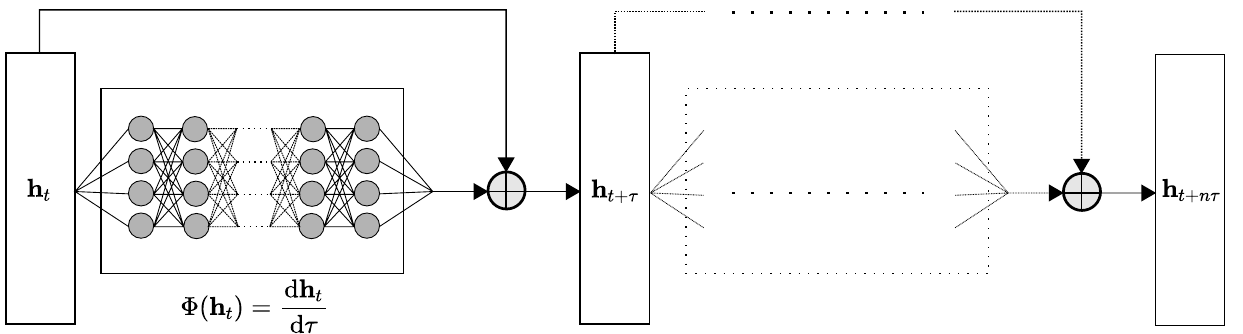
Figure 4. Neural ODE: For a dynamical system, we discretize a single step into n intervals of time τ . For each interval, we use a Multi Layer Perceptron (MLP) to approximate the forward derivative. Using a residual connection, we can approximate a forward integration for a time interval τ . We repeat this process n times for the full